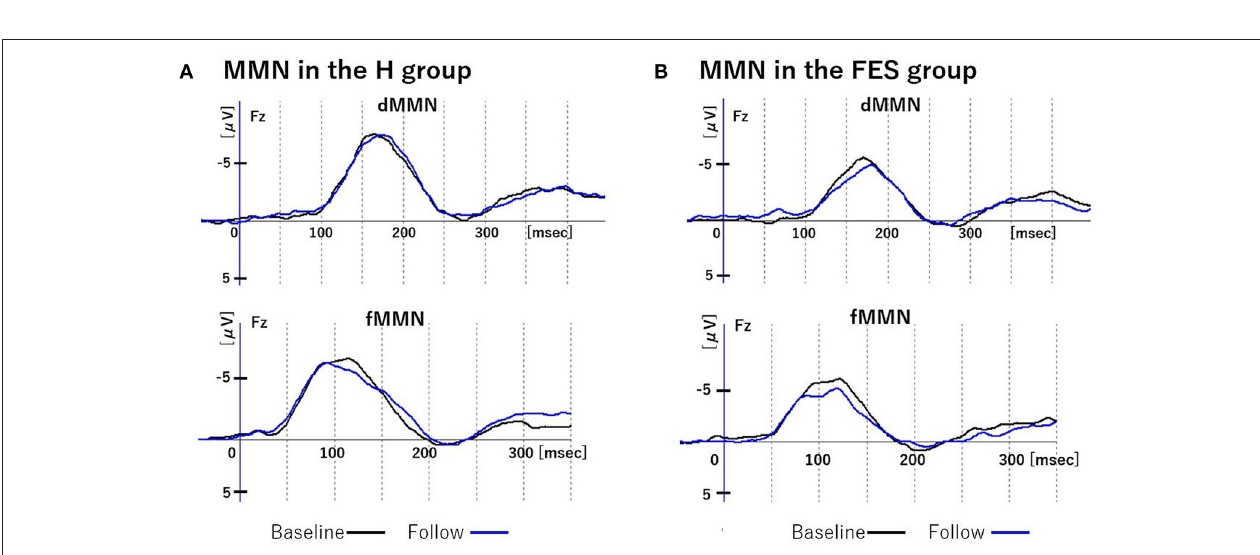
FIGURE 3 | Changes in MMN over time. Figure shows grand average waveforms of dMMN and fMMN at Fz. (A) shows the baseline and follow-up of MMN in group H. (B) shows the baseline and follow-up of MMN in group FES. Abbreviations: dMMN, duration mismatch negativity; fMMN, frequency mismatch negativity; H, healthy controls; FES, first episode schizophrenia; R, schizophrenia remitter; NR, schizophrenia